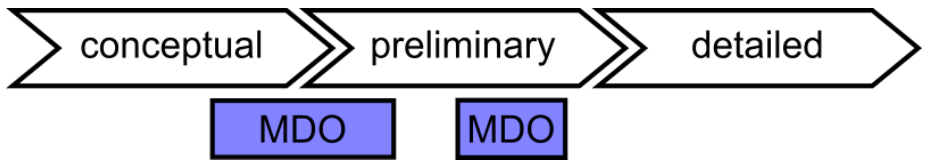
Figure 13. The design phases and the use of